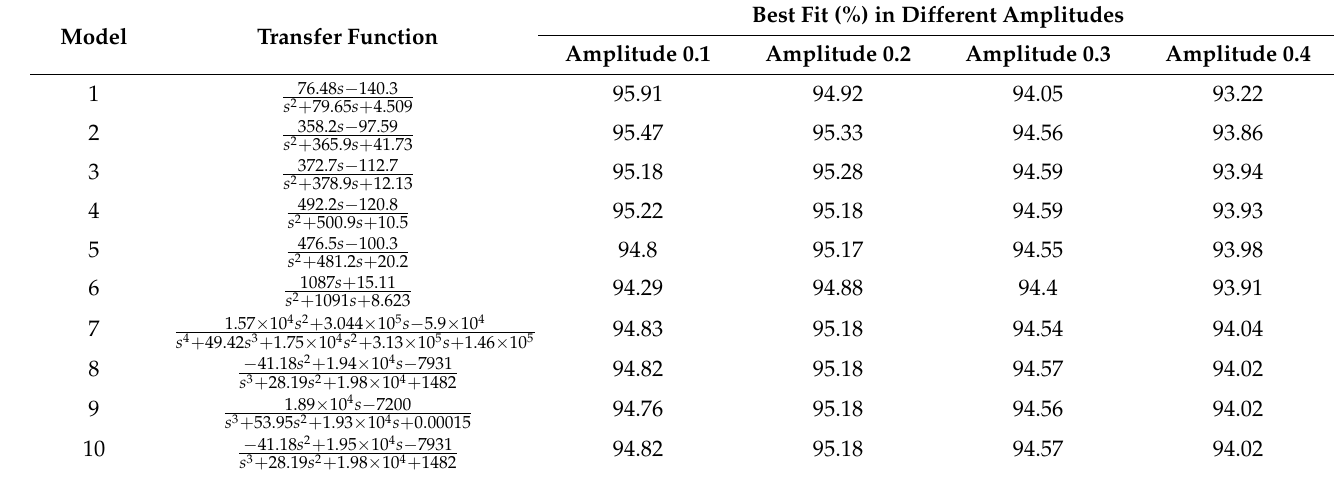
Figure 3. Current vs. time. Table 1. Performance comparison of different systems with 0.4 amp current.